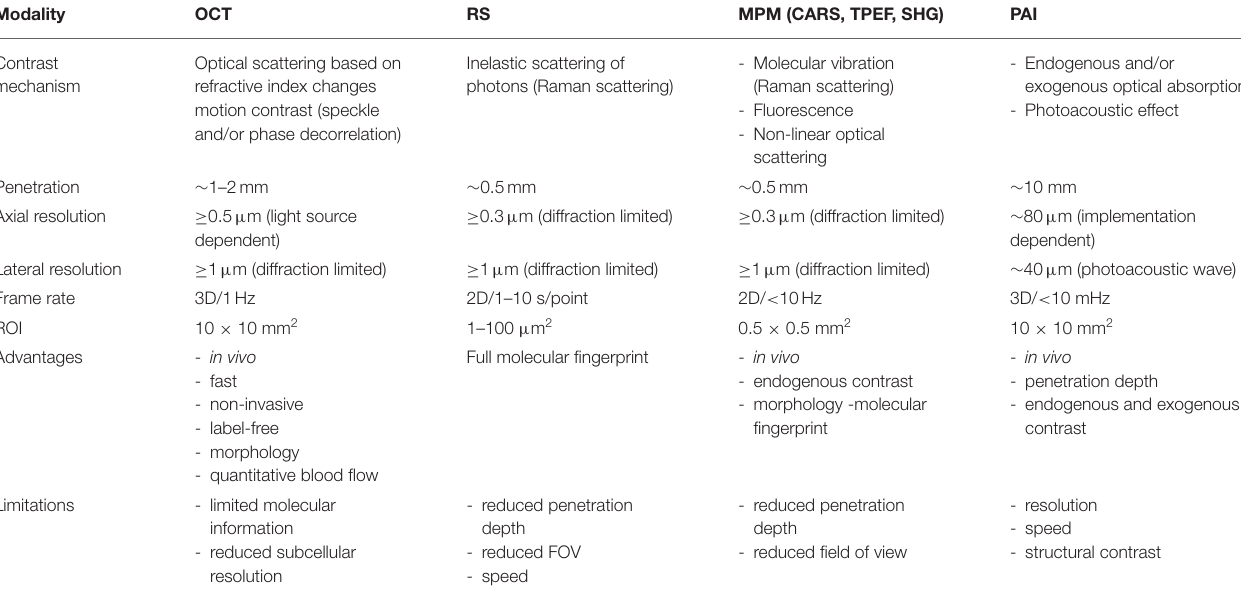
TABLE 2 | Imaging parameters, advantages and limitations of the most used in-vivo microscopy techniques in preclinical research.